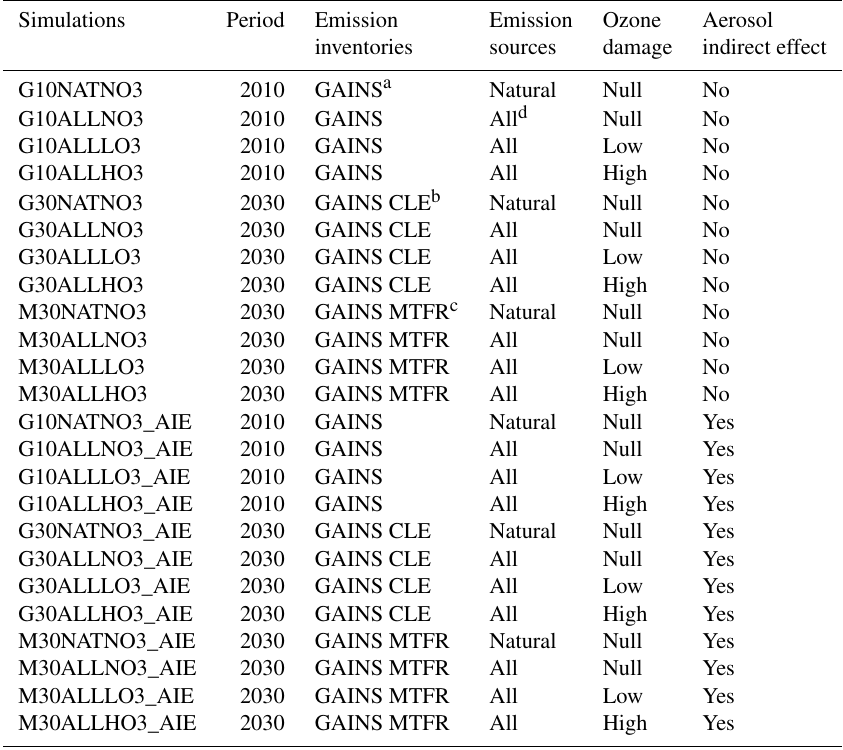
Table 2. Summary of 24 online simulations with the ModelE2–YIBs model.